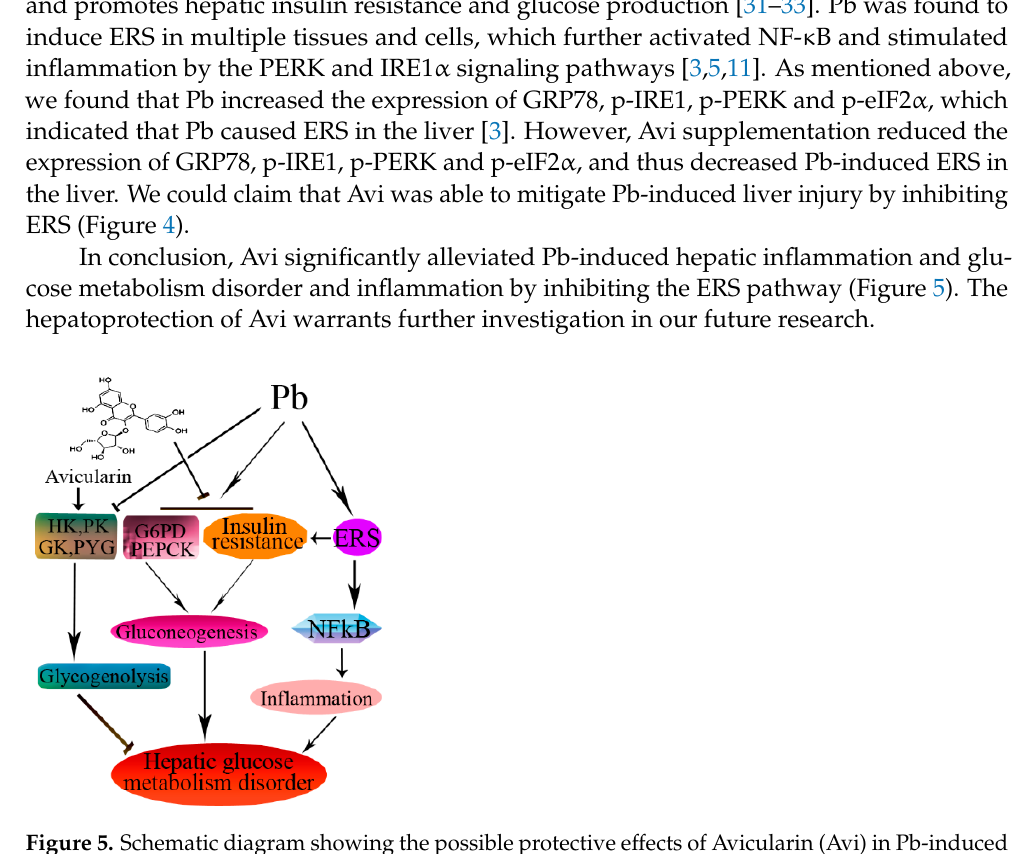
Figure 5. Schematic diagram showing the possible protective effects of Avicularin (Avi) in Pb-induced liver injury. The → indicates activation or induction, and (cid:97) indicates inhibition or